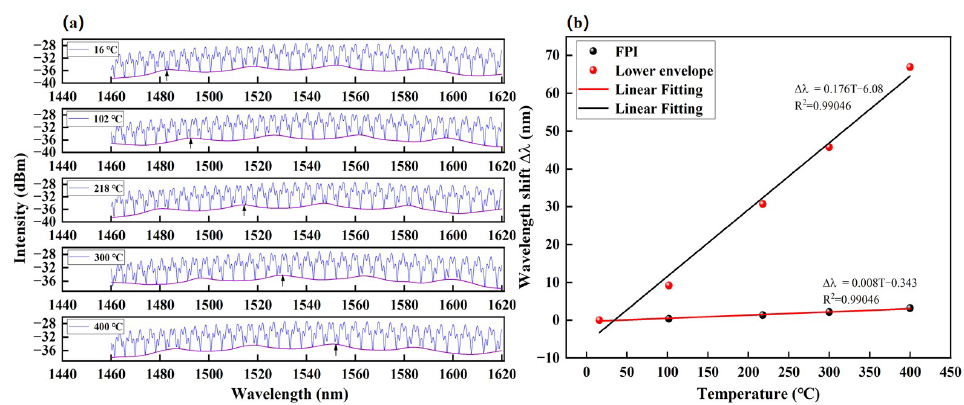
Figure 8. ( a ) The shift of the reflective spectra envelope versus temperature. ( b ) The linear fitting between the envelop wavelengths and different temperatures.